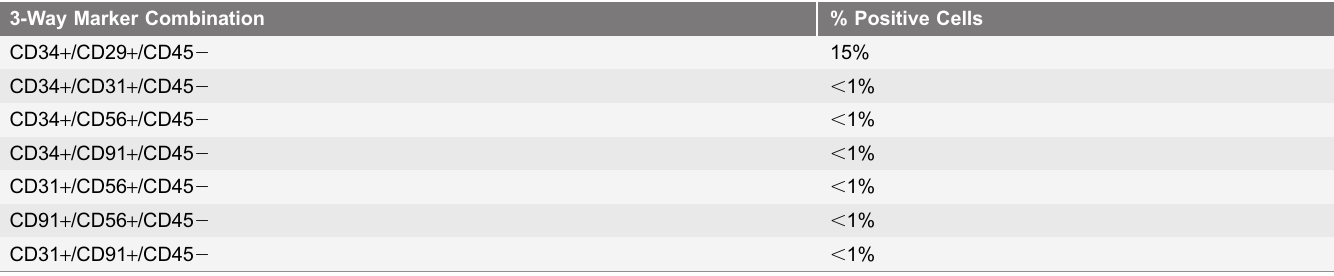
Table 2. Three-way FACS Analyses Identifies Likely Targets of Markers Used to Sort.